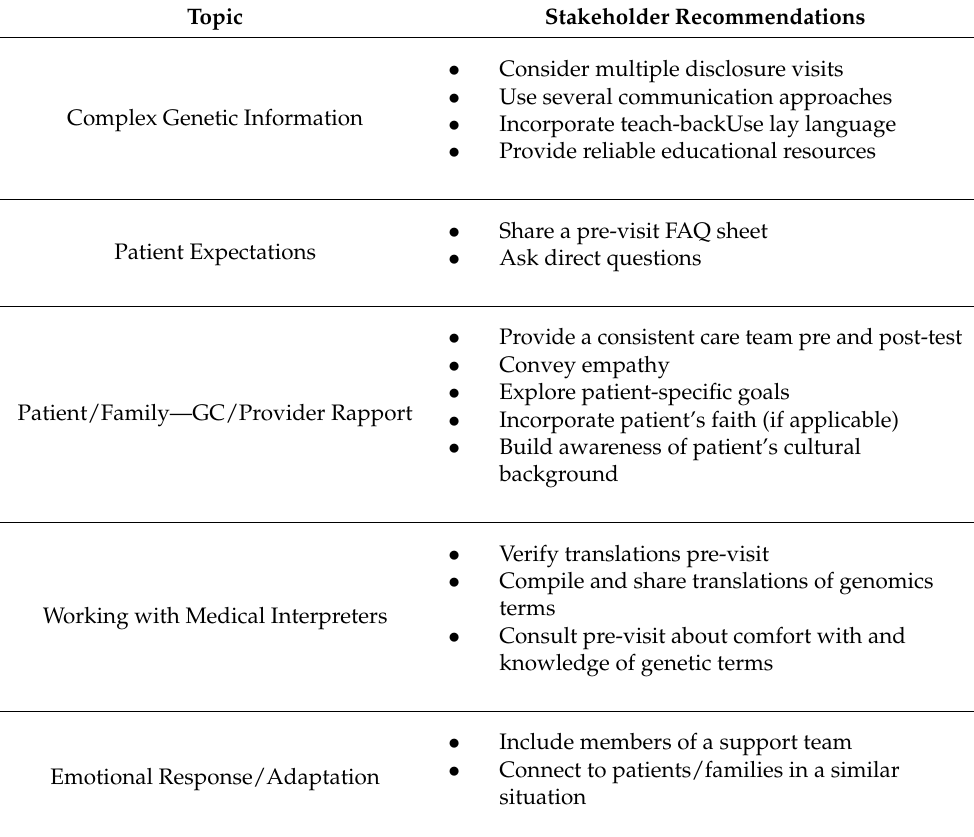
Table 3. Topics and recommendations from patient/community stakeholder